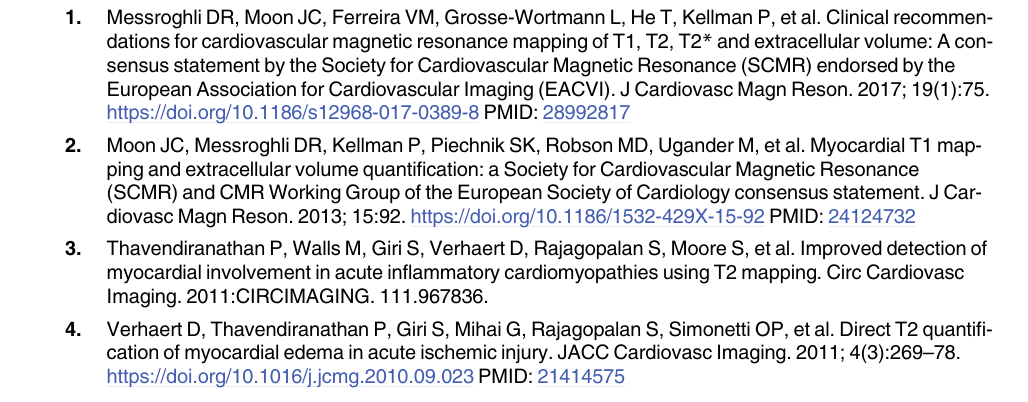
and T maps and weighted images for all sequences. 1 2 1